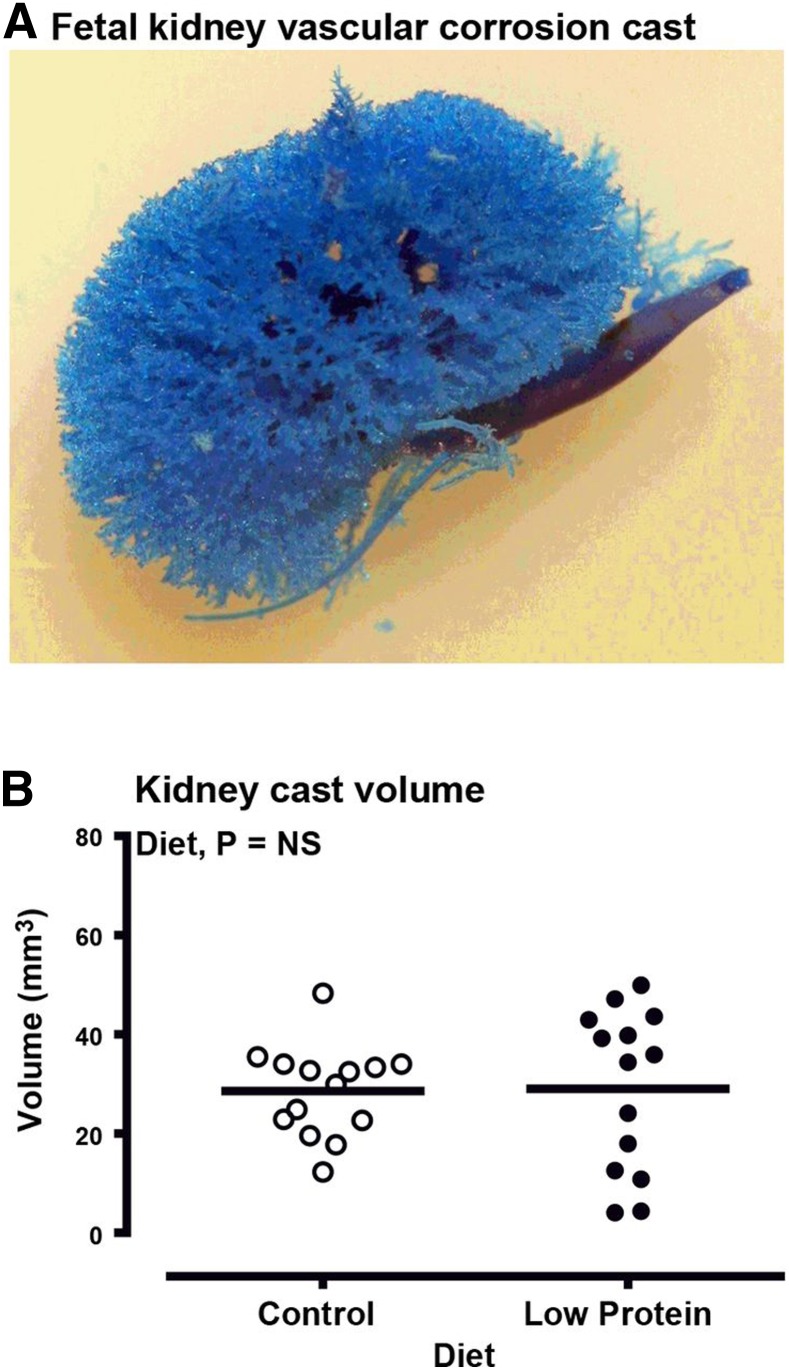
Fetal kidney macrovasculature is unaffected by maternal LP diet. A) Representative vascular corrosion cast of a fetal kidney generated using Batson's No. 17 Plastic Replica and Corrosion Kit. Volume and surface area of resin casts was quantified using a Nanotom high-resolution micro-CT scanner. B) Dot plot of quantified volumetric data from casts, line at predicted mean for each group. Data are for ewes fed a CP diet (control fetuses: male, n=8; female, n=7) or LP diet from d 0 to 65 of gestation (LP-exposed fetuses: male, n=8; female, n=8). Data were analyzed by the general linear mixed model for the fixed effects of diet, sex, and their interaction term (diet×sex) using Genstat 15. Supplemental Movie S1 illustrates 3D volumetric acquisition of vascular corrosion cast data. NS, nonsignificant. Values of P < 0.05 were considered significant.